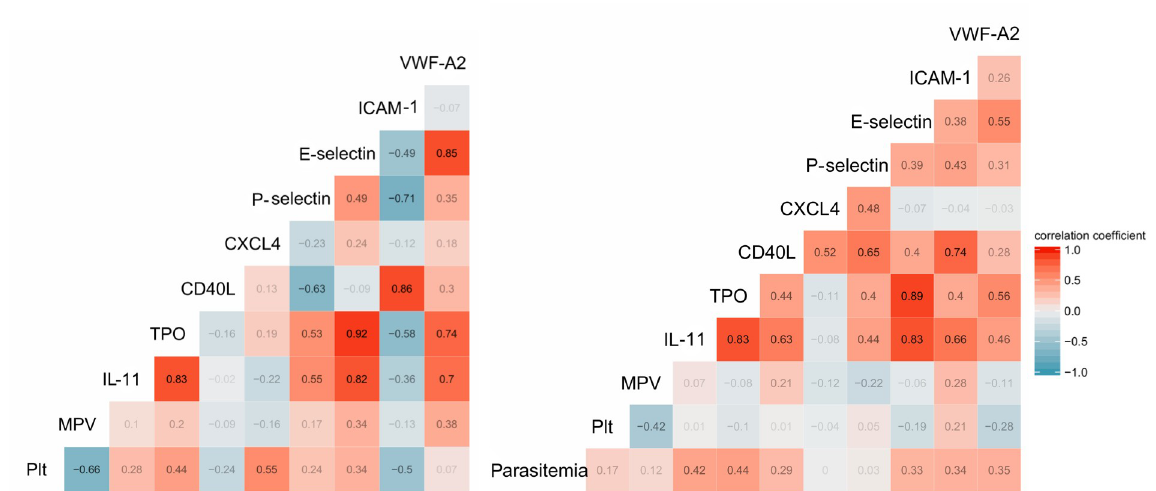
Fig 5. Correlation values. The value for each pair of correlation between the parameters measured in the plasma from controls (A) and patients (B). Plt: platelet